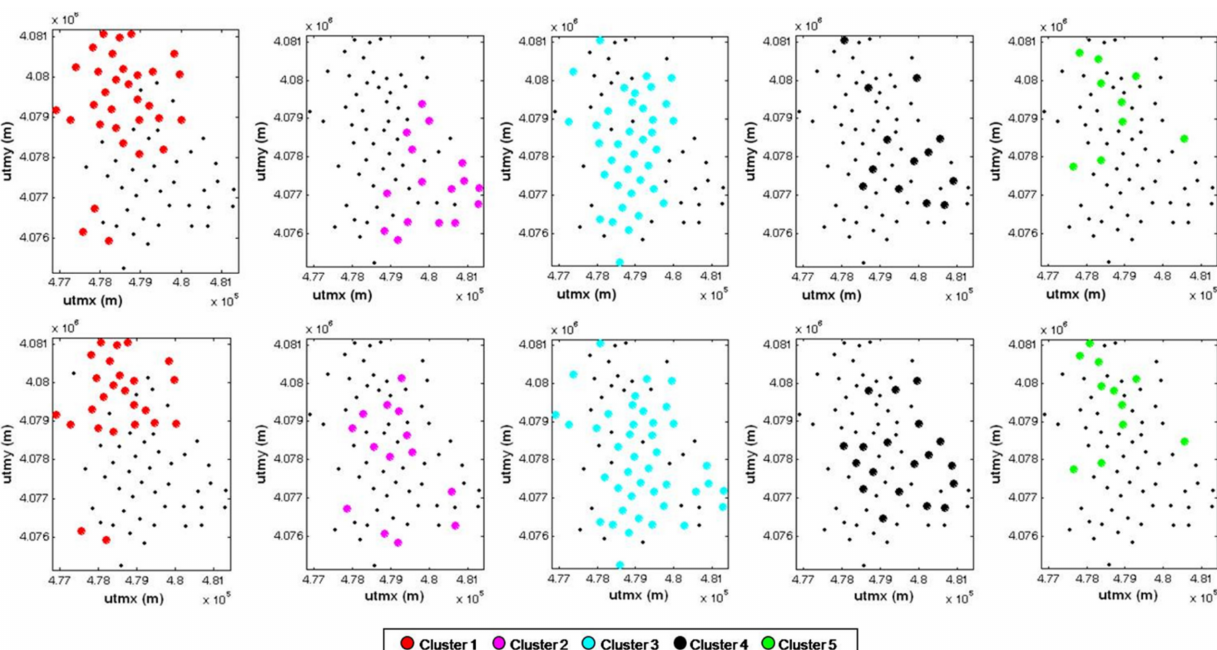
Figure 3. Comparison between the distribution in the spatial domain ( x and y coordinates) of the points of the clusters, obtained by performing a preliminary analysis of the data ( top ) and by applying the non-hierarchical algorithm with automatically chosen centroids ( bottom ).